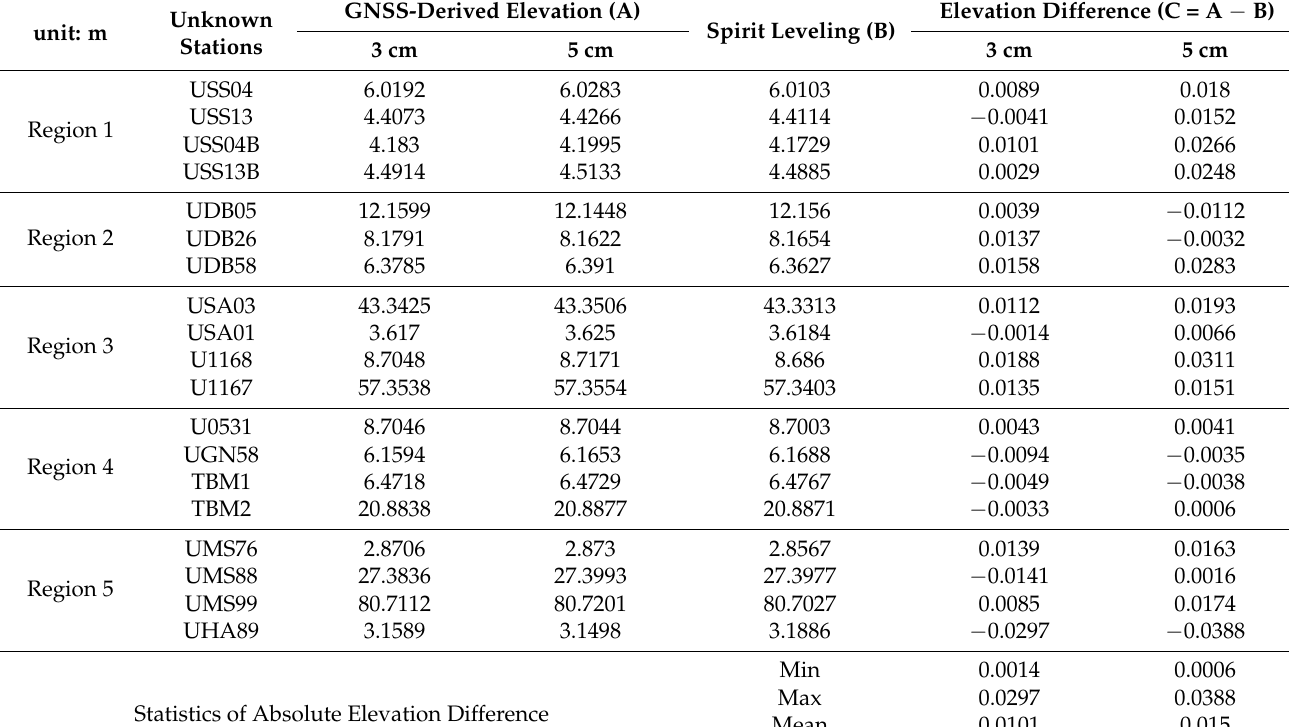
Figure 3. Elevation differences between GNSS-derived height determination and spirit leveling for target precisions of 3 and 5 cm.